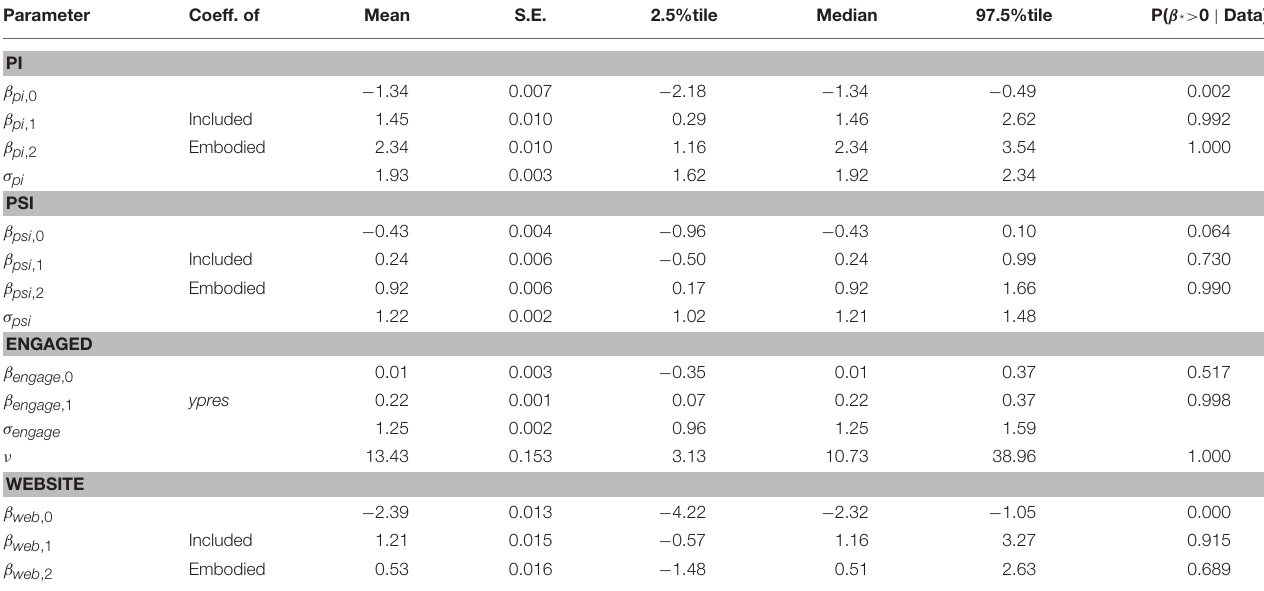
TABLE 2 | Posterior estimates, standard errors and 95% credible intervals and posterior probabilities that the parameters are positive. Parameter Coeff.